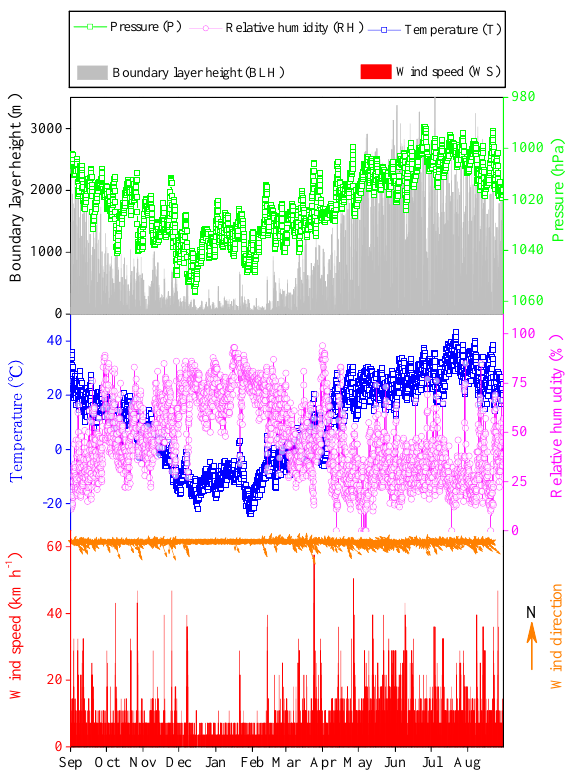
Figure 2. Meteorological parameters at the observation site from September 2014 to August 2015 for every 3h.